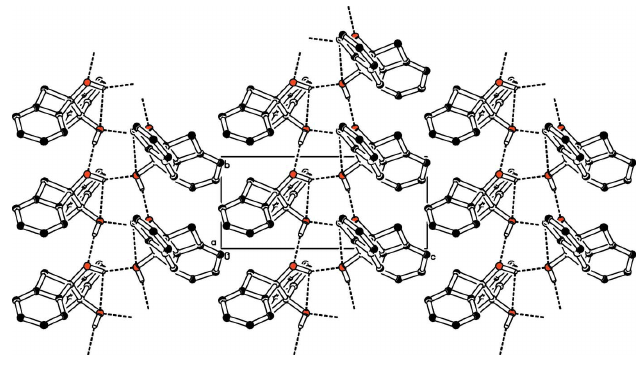
Figure 2 Partial packing diagram, view along the a axis. Hydrogen bonds are drawn with dashed